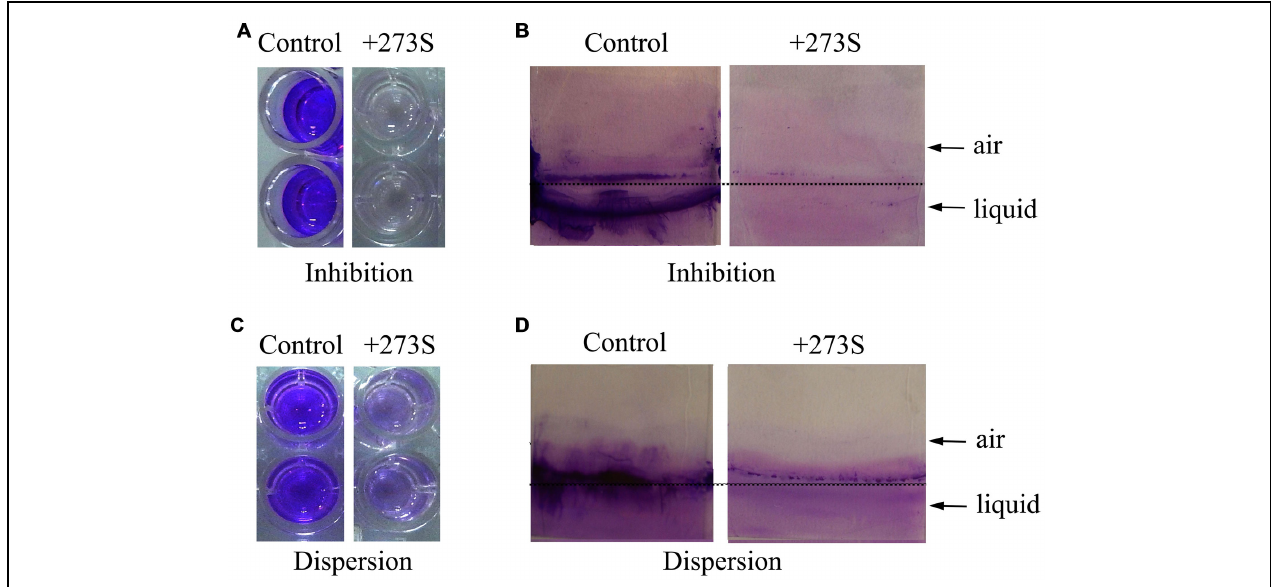
FIGURE 1 | Effects of Pseudomonas stutzeri 273 supernatant on biofilm formation and dispersion of P. aeruginosa PAO1. (A) Biofilm formation of P. aeruginosa PAO1 in 96-well polystyrene plate wells in the presence or absence of 10% supernatant of P. stutzeri 273 (273S) and duplicate wells are shown. (B) Biofilm formation of P. aeruginosa PAO1 on glass slides in the presence or absence of 10% 273S. As for the controls, the same amount of LB broth was used. (C) Preformed biofilm dispersion of P. aeruginosa PAO1 in 96-well polystyrene plate wells in the presence or absence of 10% 273S and duplicate wells are shown. (D) Preformed biofilm dispersion of P. aeruginosa PAO1 on glass slides in the presence or absence of 10% 273S. As for the controls, the same amount of LB broth was